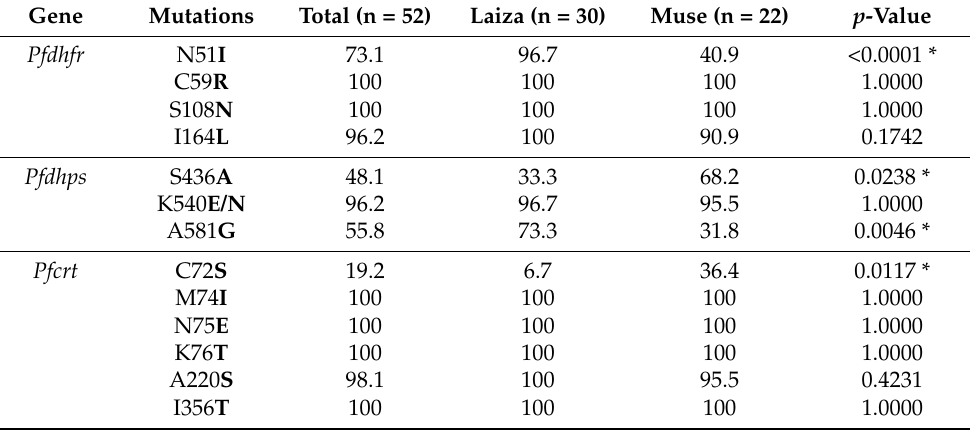
Figure 2. Correlation between the IC 50 values of cultured parasite isolates to 11 antimalarial drugs by Spearman’s test. The degree of correlation is color-coded, and coefficients are shown below the diagonal. *, **, ***, and **** indicate significance at 0.01 < P < 0.05, 0.001 < P < 0.01, 0.0001 < P < 0.001, and P < 0.0001, respectively. Abbreviations are the same as in Figure 1. Table 2. The prevalence of mutations (%) in genes associated with drug resistance in the two border